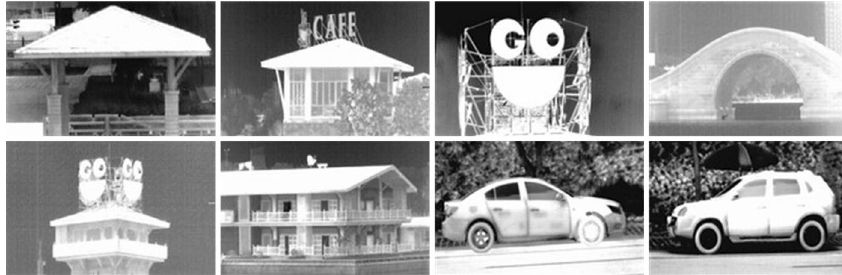
Fig. 11. 108 168 pixel infrared template images ×